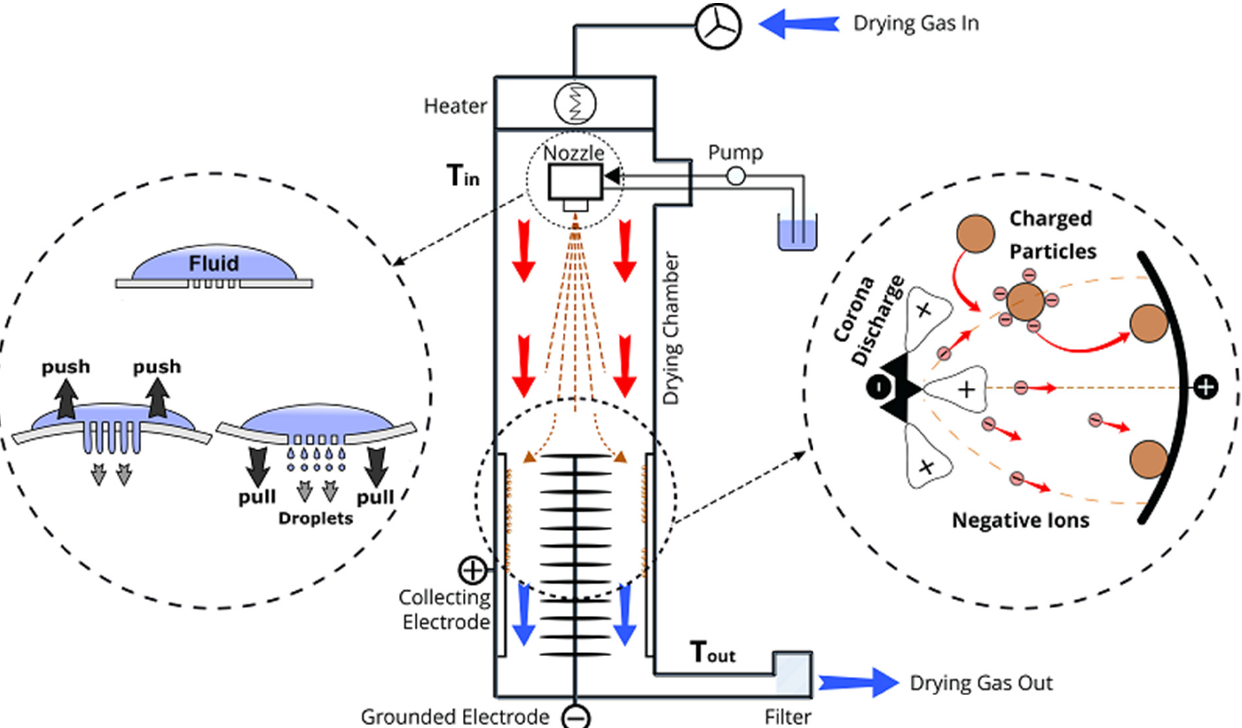
Figure 1. A schematic diagram of the Büchi Nano Spray Dryer B-90 and its characteristic elements (illustration adapted from the operation manual [13], with permission). The left and the right circles illustrate the functioning principles of the vibrating-mesh atomizer and the electrostatic particle collector, respectively. 𝑇 (cid:2919)(cid:2924) and 𝑇 (cid:2925)(cid:2931)(cid:2930) are the inlet and the outlet temperatures.